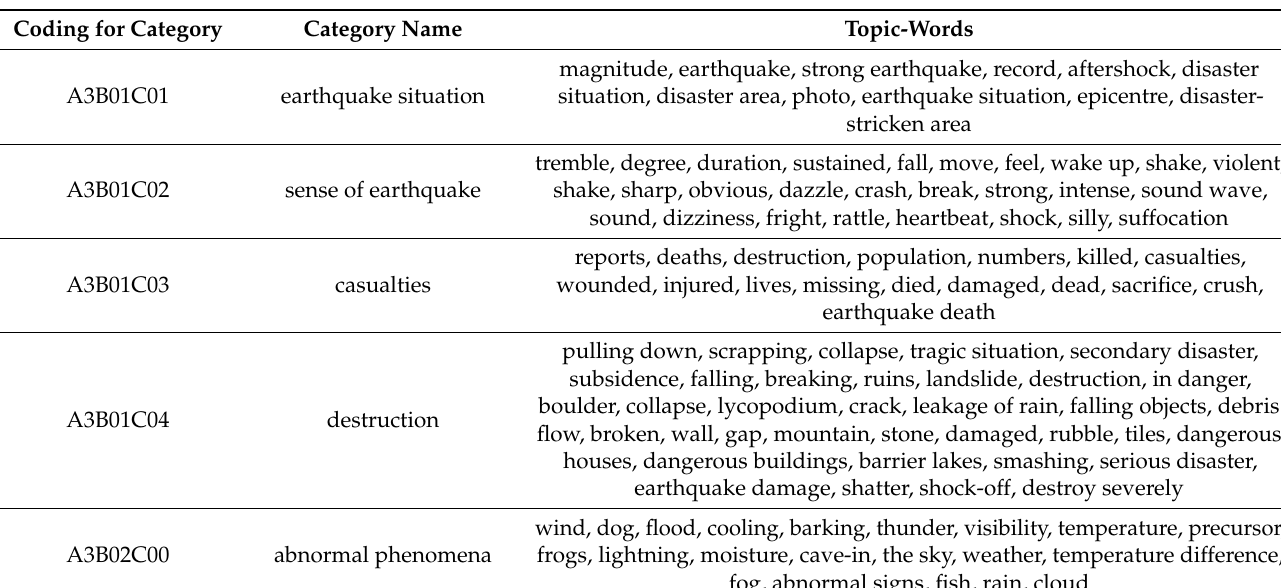
Table 5. Part of the fine-grained topic-word sets.